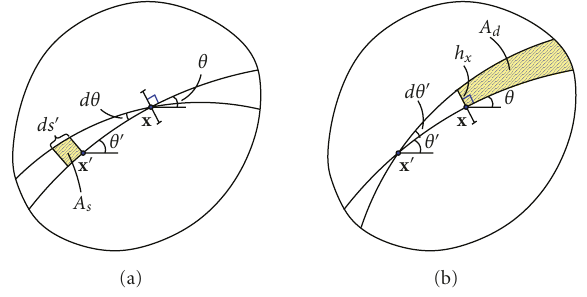
Figure 3: Derivation of expression (18) for the scalar